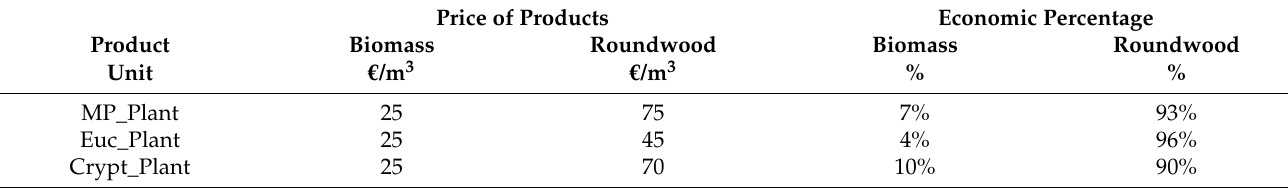
Table 8. Calculation of percentages of economic allocation.